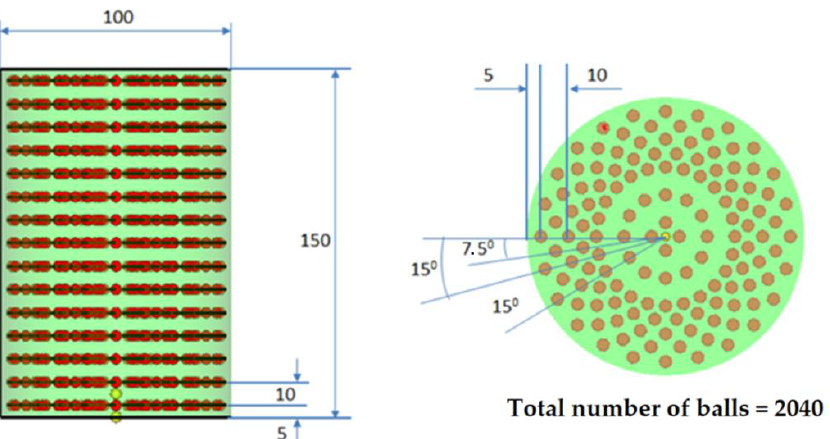
Figure 2. Model no. 1 for the damper with 1320 balls.